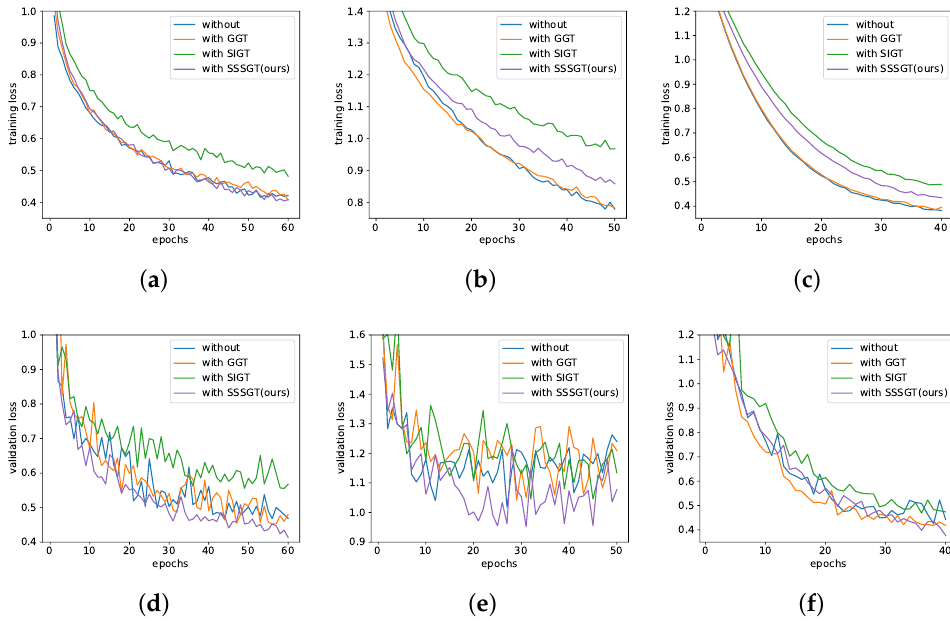
Figure 19. Training and validation loss curves of SDFCNv2 model using different gamma-transform- based data augmentation methods on different datasets. ( a ) Training loss curves on Potsdam dataset; ( b ) Training loss curves on Evlab dataset; ( c ) Training loss curves on Songxi dataset; ( d ) Validation loss curves on Potsdam dataset; ( e ) Validation loss curves on EvLab dataset; ( f ) Validation loss curves on Songxi dataset.